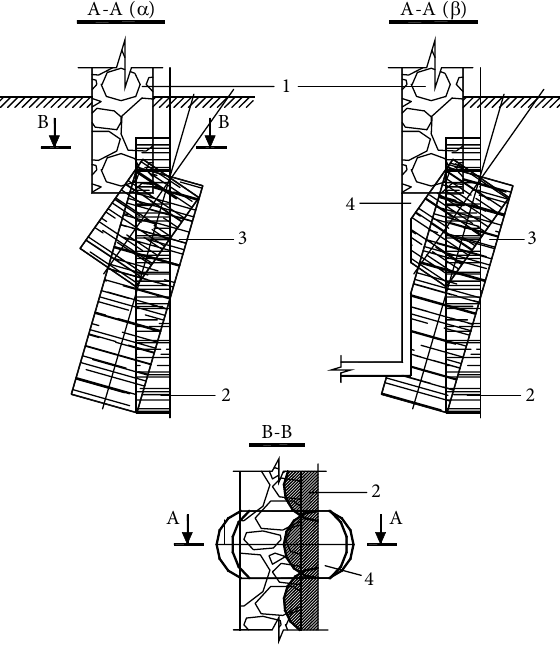
Fig. 10. Deepening foundations using jet grouting i